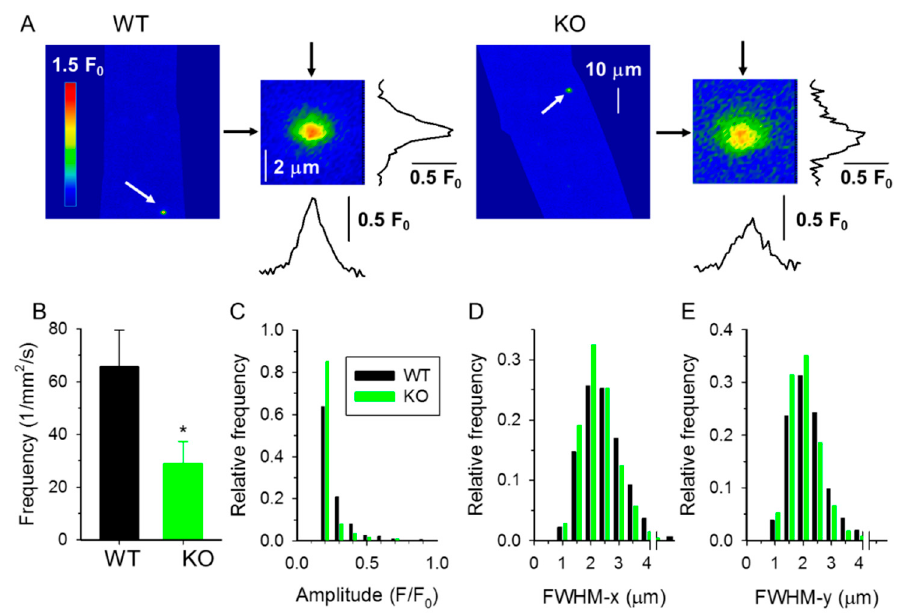
Figure 5. Parameters of Ca 2+ release events in 4-month-old WT and sAnk1 KO mice. ( A ) A single XY image of normalized fluorescence (F/F 0 ). The images were obtained by selecting one image from a series (as presented in Figure 4) and normalizing to baseline fluorescence (F 0 ) after removing the background (determined outside of the fiber). Enlarged portions (black arrows) present the Ca 2+ release events (CREs) marked in the original image together with their spatial profiles parallel (x) or perpendicular (y) to the longitudinal axis of the fiber. ( B – E ) Pooled data for CRE frequency ( B ), amplitude ( C ), and full width at half maximum (FWHM) in x ( D ) and in y ( E ) directions for WT (number of events, n = 1084) and KO ( n = 1231) fibers.